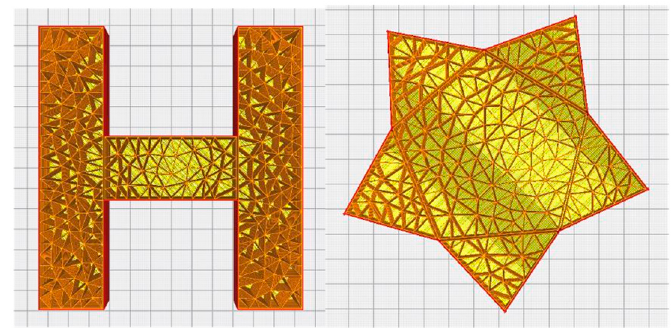
Figure 6. Cura simulation model.